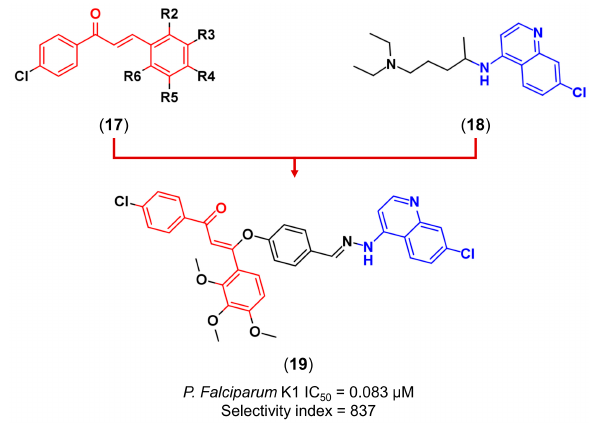
Figure 7. Molecular hybrid obtained from a combination of 4'-chlorochalcone (red) and chloroquine (blue)